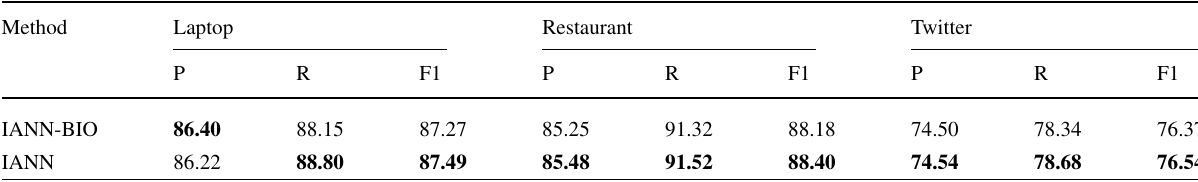
Table 5 The experiments of the proposed model on both AO tags and BIO tags